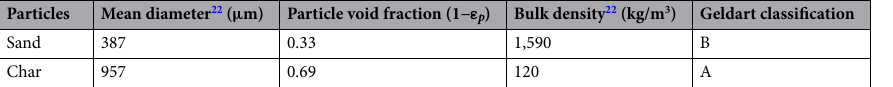
Table 4. Properties of